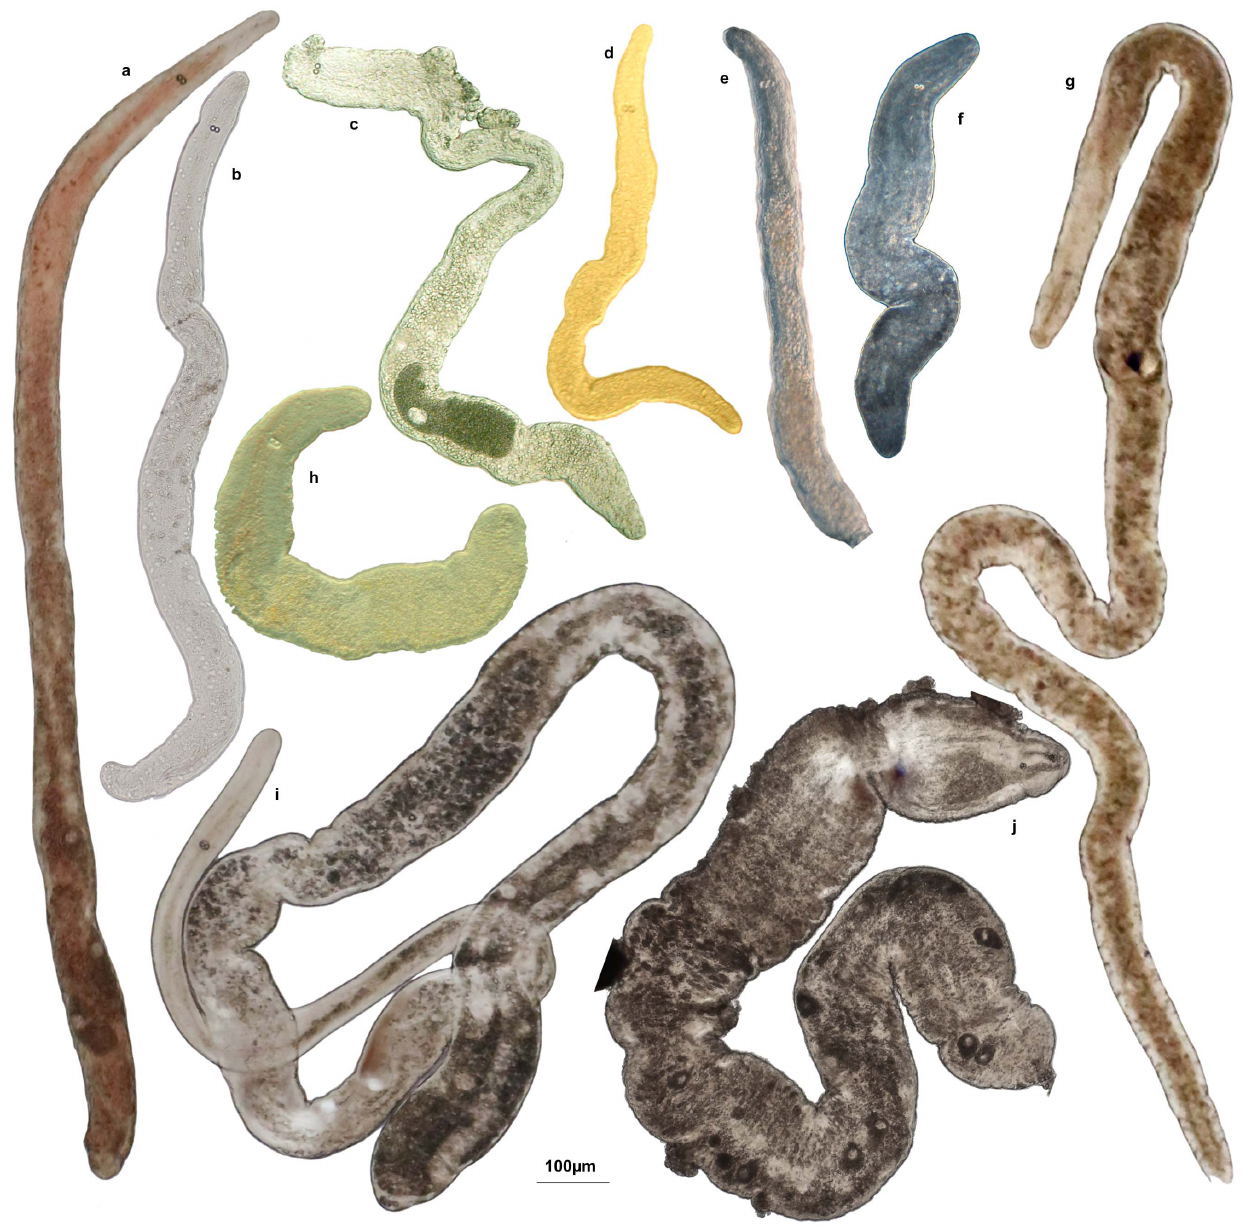
Figure 1. Morphological variation within the genera Nemertinoides and Sterreria . Light microscope photographs of live specimens in squeeze preparation. a) Sterreria rubra from Southern Portugal, b) S. psammicola from Southern Portugal, c) S. martindalei n.sp. from Waimanolo, Hawaii, d) S. ylvae n.sp, from Waimanolo, Hawaii, e) S. variabilis n.sp. from New Caledonia, f) S. variabilis n.sp. from Bermuda, g) Nemertinoides elongatus from Southern Portugal, h) S. rubra from Helgoland, North Sea, i) N. glandulosum n.sp. from Southern Portugal, j) N. wolfgangi n.sp. from Croatia.